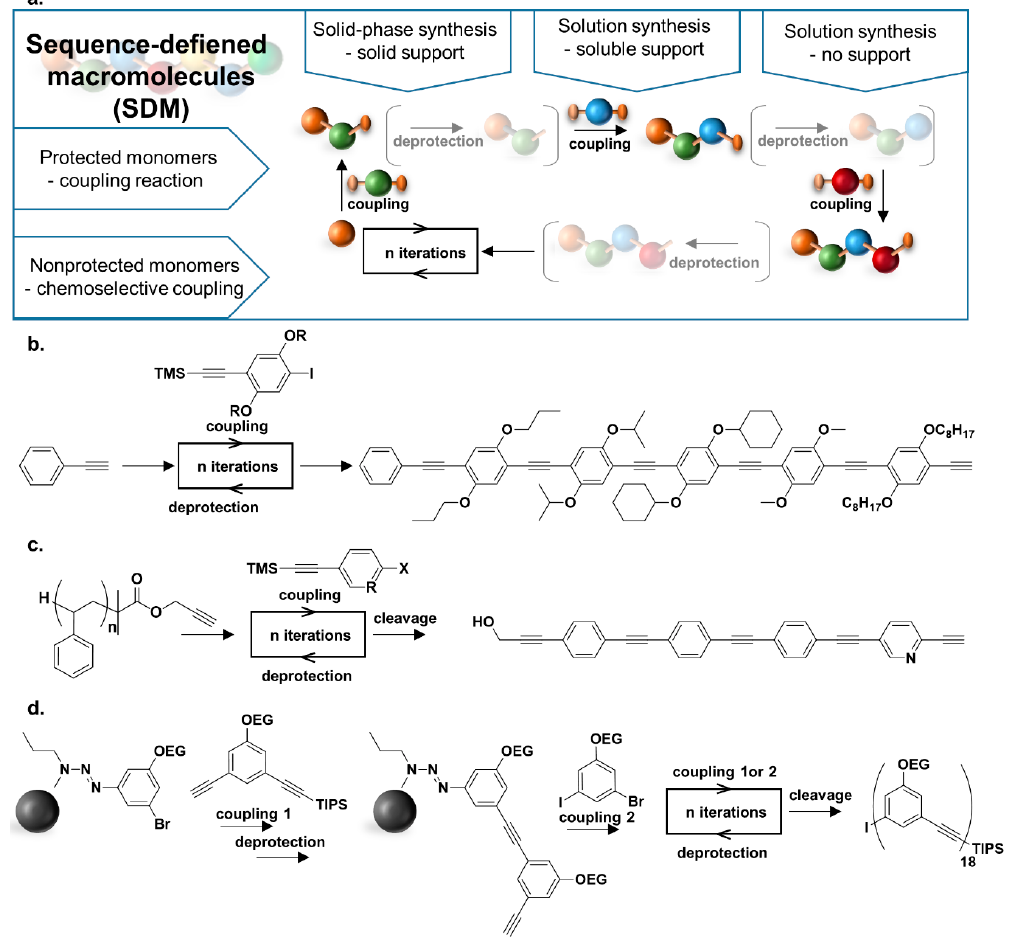
Figure 1. ( a ) The main approaches for the synthesis of sequence-defined conjugated macromolecules. Sequence-defined macromolecules can be obtained by multistep-growth synthesis using three main approaches: solid-phase synthesis, synthesis on soluble support, or solution synthesis. The monomers are used in a protected form that demands performance of the deprotection step after each coupling or by chemoselective reactions where monomers are equipped with orthogonal functional groups. The examples are of ( b ) solution synthesis [42], ( c ) synthesis on soluble support [6], and ( d ) solid-phase synthesis